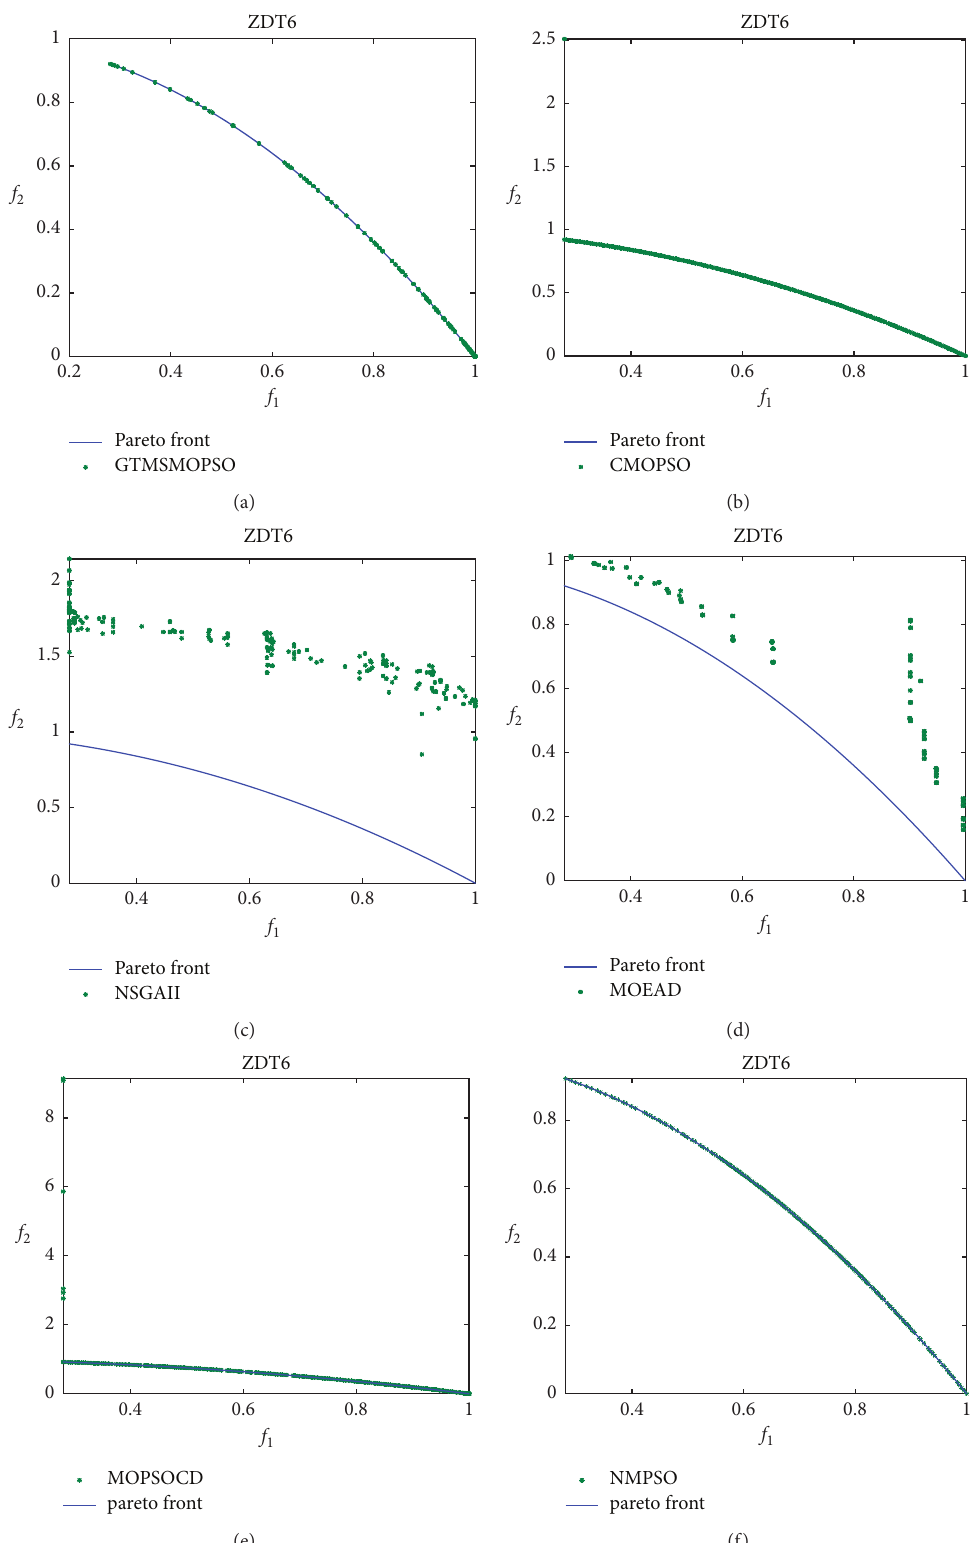
Figure 6: Pareto frontier effect of three different algorithms for ZDT6